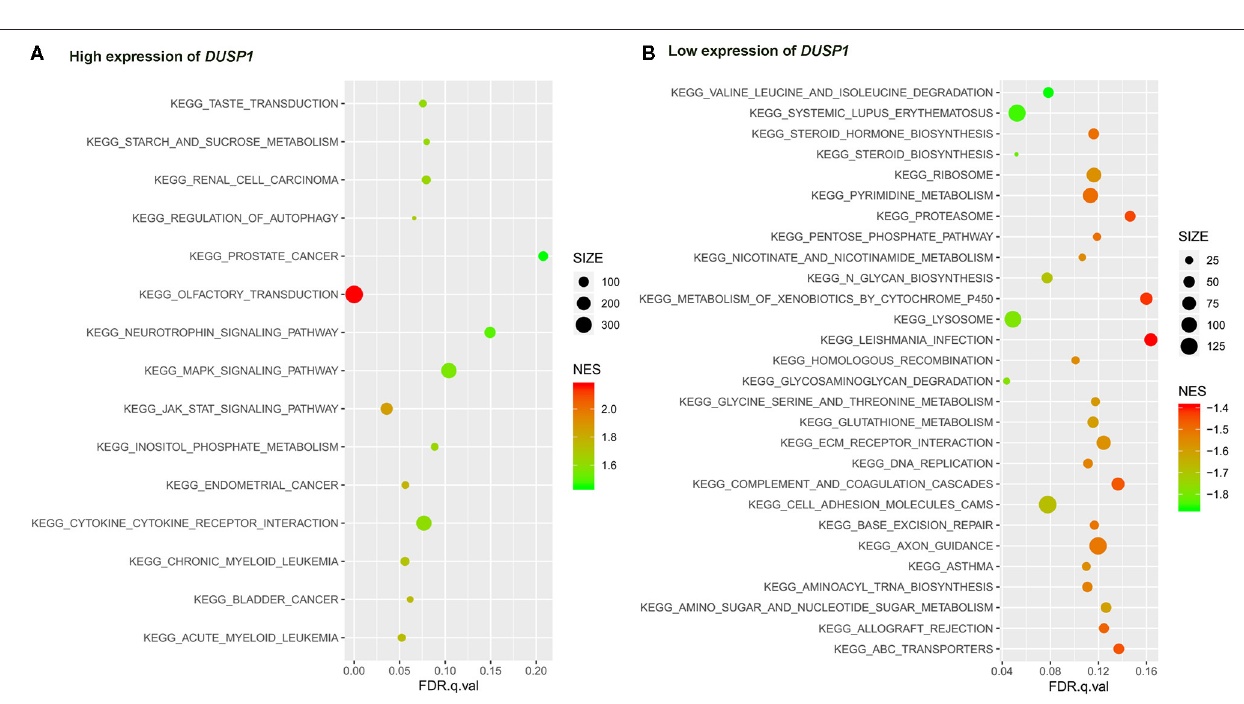
FIGURE 6 | The results of the GSEA on the KEGG pathway. (A) KEGG pathway in the high expression of DUSP1 in AV fistula and (B) KEGG pathway in the low expression of DUSP1 in AV fistula. The size of the node represents the number of genes under the gene set. The color of the node represents the NES of the gene set. The horizontal axis represents the level of q